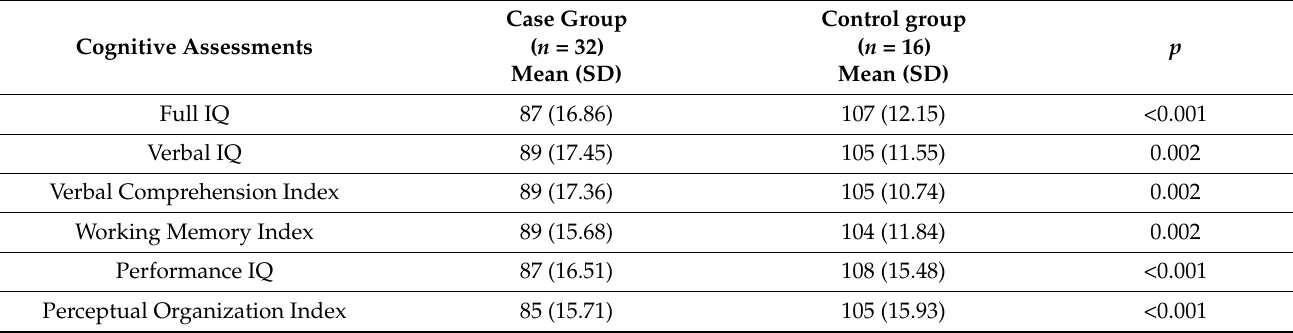
Table 4. Cognitive assessments at an early school age.